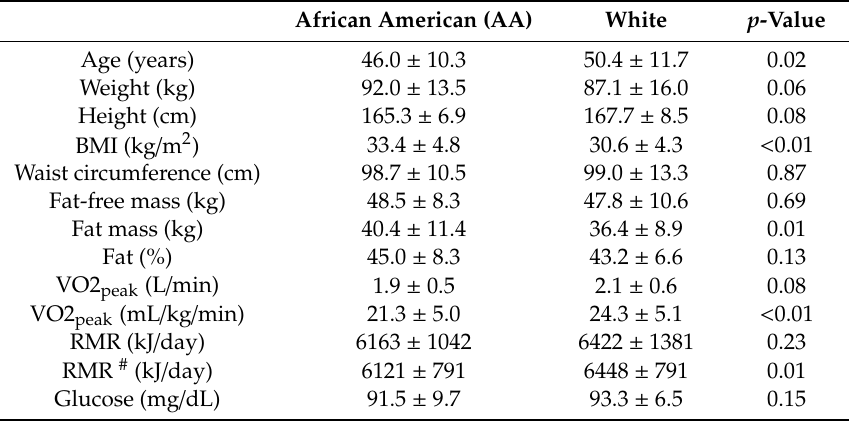
Table 1. Demographics, anthropometry, body composition, peak oxygen uptake, and resting metabolic rate in African American (AA) and White Examination of Mechanisms of Exercise-Induced Weight Compensation (E-MECHANIC) participants at